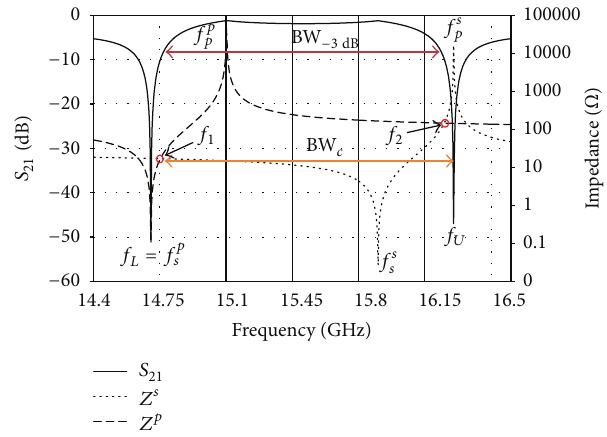
Figure 3: Working principle and design parameters of a ladder-type FBAR